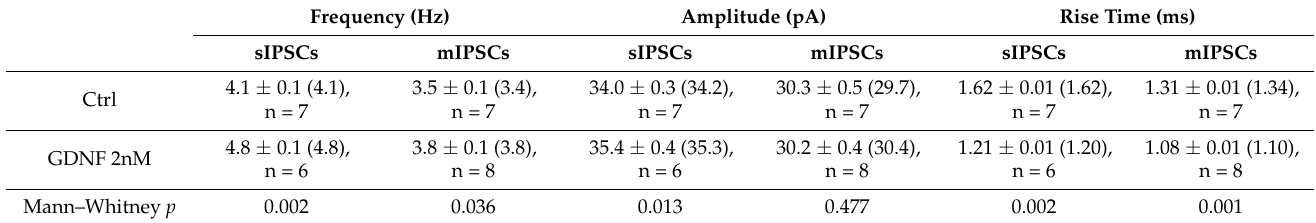
Table 1. Comparison of IPSC averages ± standard error of mean (and median) by cell following control and GDNF incubation for 1 h. Frequency, amplitudes, and rise time values of IPSCs from control and GDNF incubated slices are shown along with the Mann–Whitney p -value. The number of cells recorded is presented as